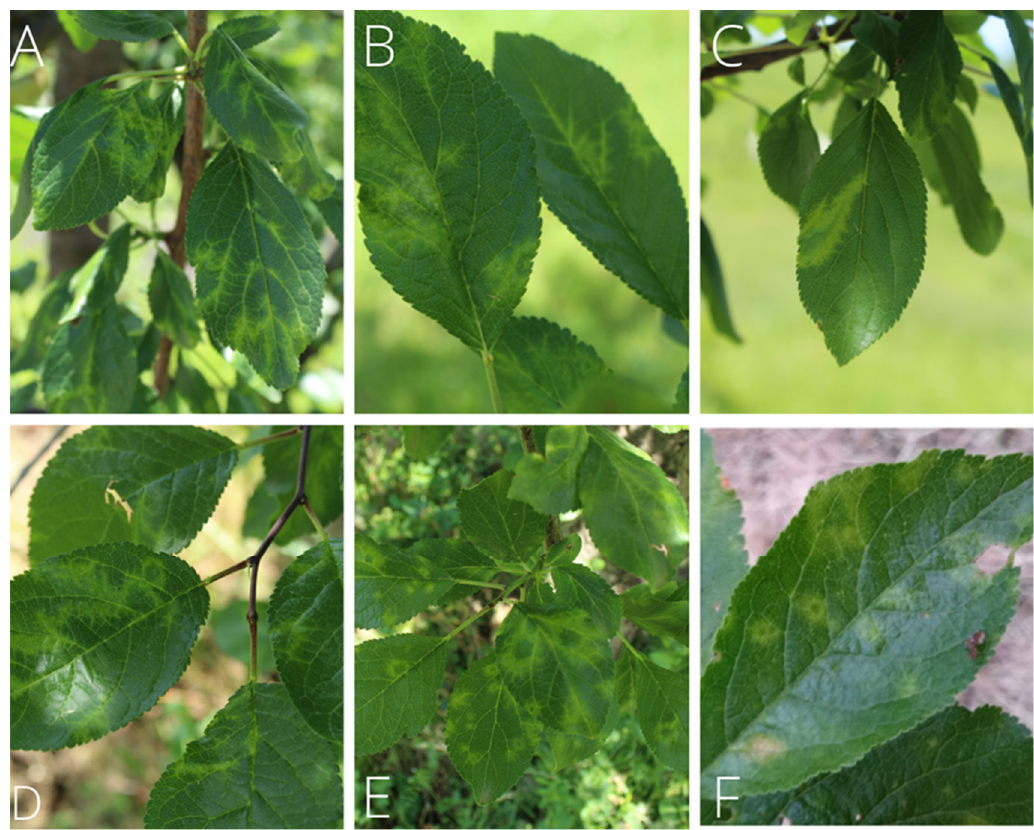
Figure 1. Symptoms associated with PPV infections. ( A ) PPV symptom expression in cv. ‘Stanley’ in the form of chlorotic ring patterns and semicircles. ( B ) Vein banding and irregular chlorotic patterns observed in cv. ‘ Č a č anska lepotica’ infected with PPV that could not be associated with any of the surveyed strains. ( C ) Irregular yellow–green pattern observed in cv. ‘Stanley’ infected with PPV ‐ D. ( D ) symptom expression of PPV ‐ D in cv. ‘Stanley’ in the form of irregular, chlorotic patterns and semicircles. ( E ) Symptom expression in the form of intensive chlorotic ring patterns in different sizes observed in cv. ‘ Č a č anska lepotica’ infected with PPV ‐ REC. ( F ) Symptom expression of PPV observed in cv. ‘Požega č a’.